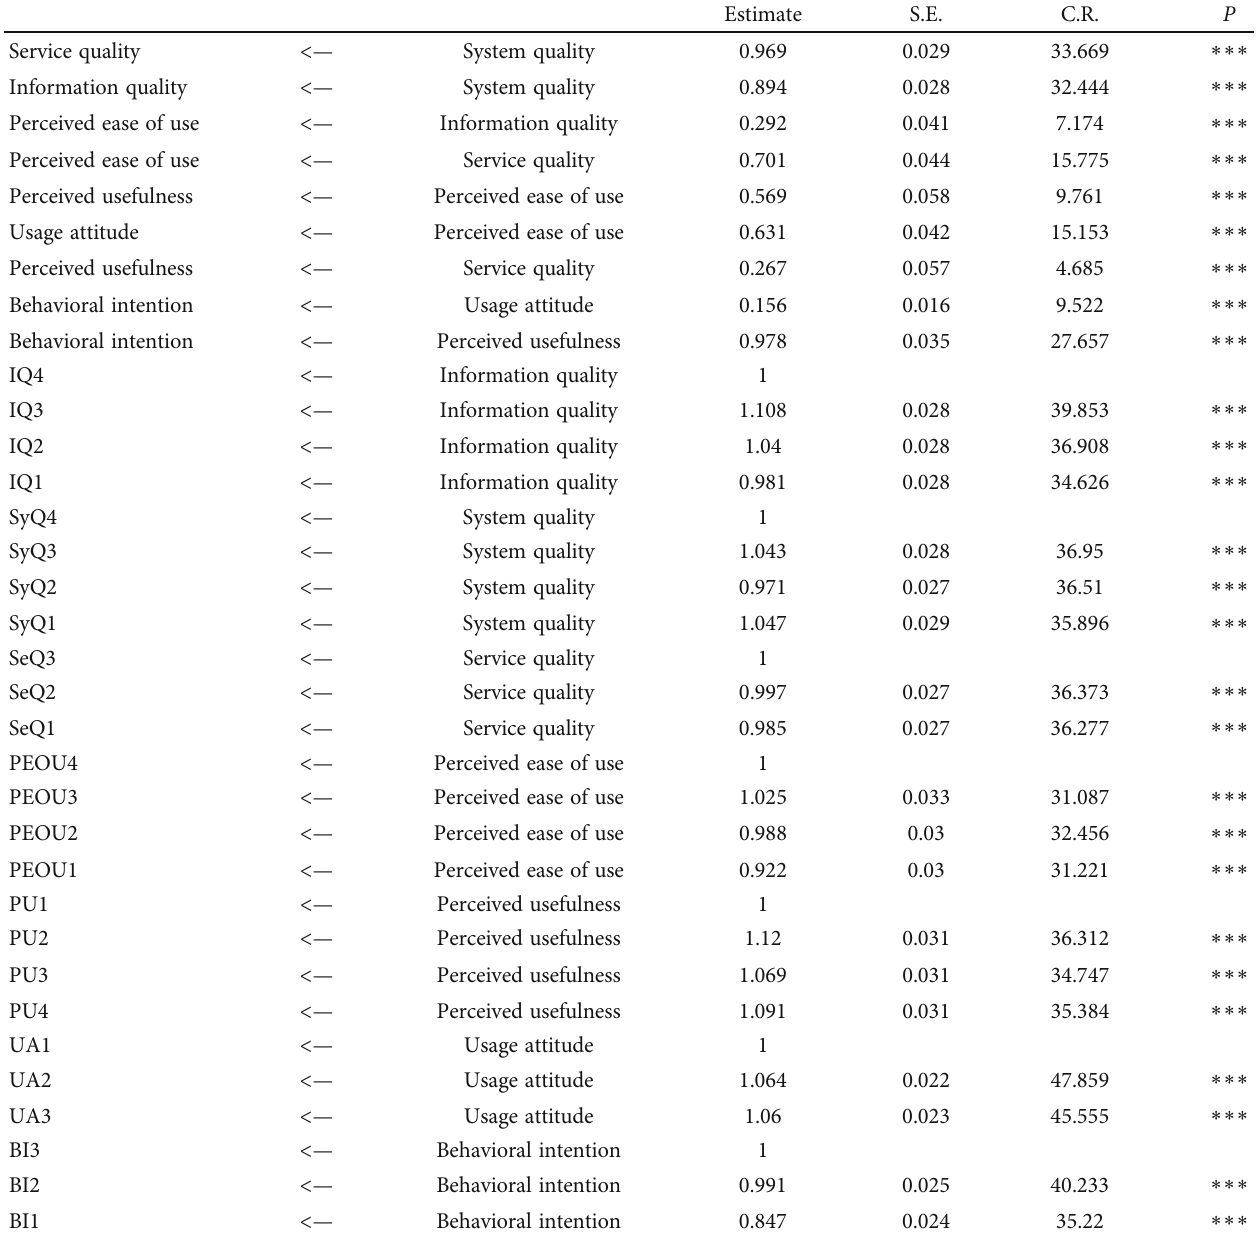
Table 4: The data of the modi fi ed structural equation